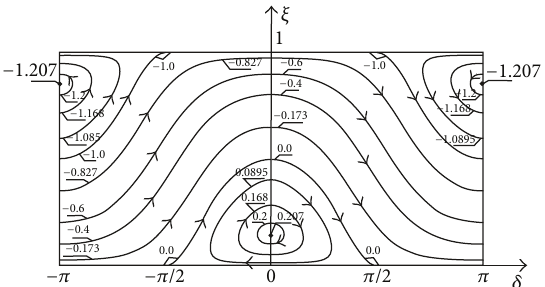
Figure 6: Phase portrait for the case of 1:1 internal resonance 𝜔 1 = (1/2)𝐾𝑏 −1 = −1 . 𝜔 2 at